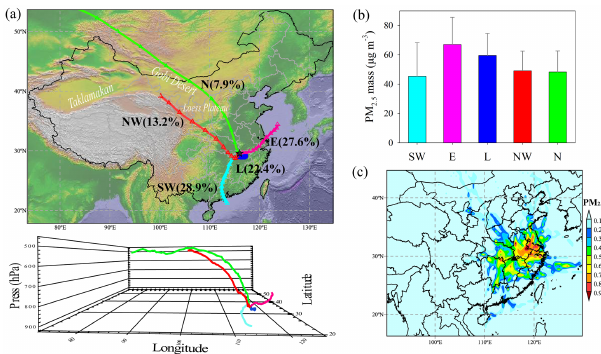
Figure 5. (a) Three-day mean trajectories arriving at Mt. Lushan, (b) averaged PM 2 . 5 concentration of five clusters, and (c) the likely source regions of PM 2 . 5 identified using PSCF plots during the ob- servation